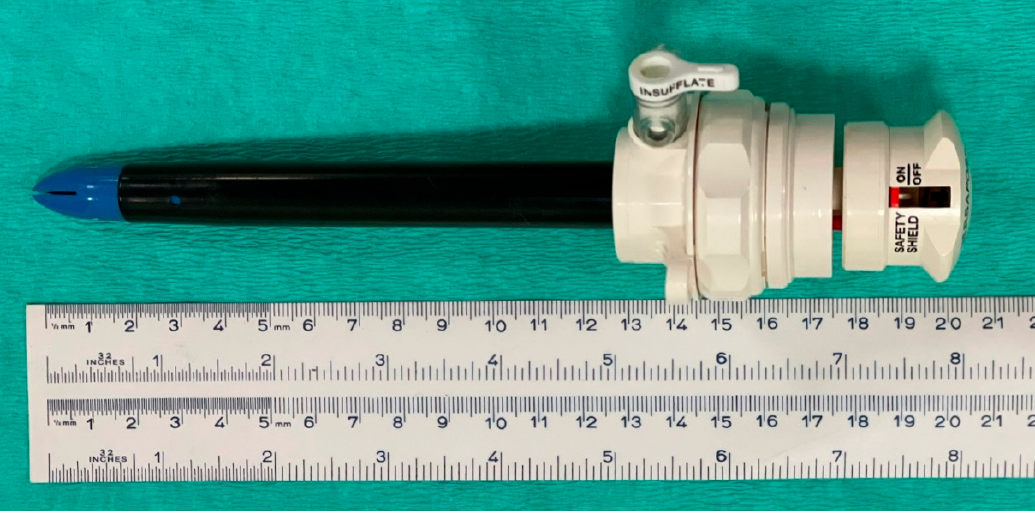
Figure 1. Device used in Group P after the induction of pneumoperitoneum: laparoscopic disposable cannula (12 mm diameter, 11 cm length). The cannula had a shielded sharp trocar of 13 cm.